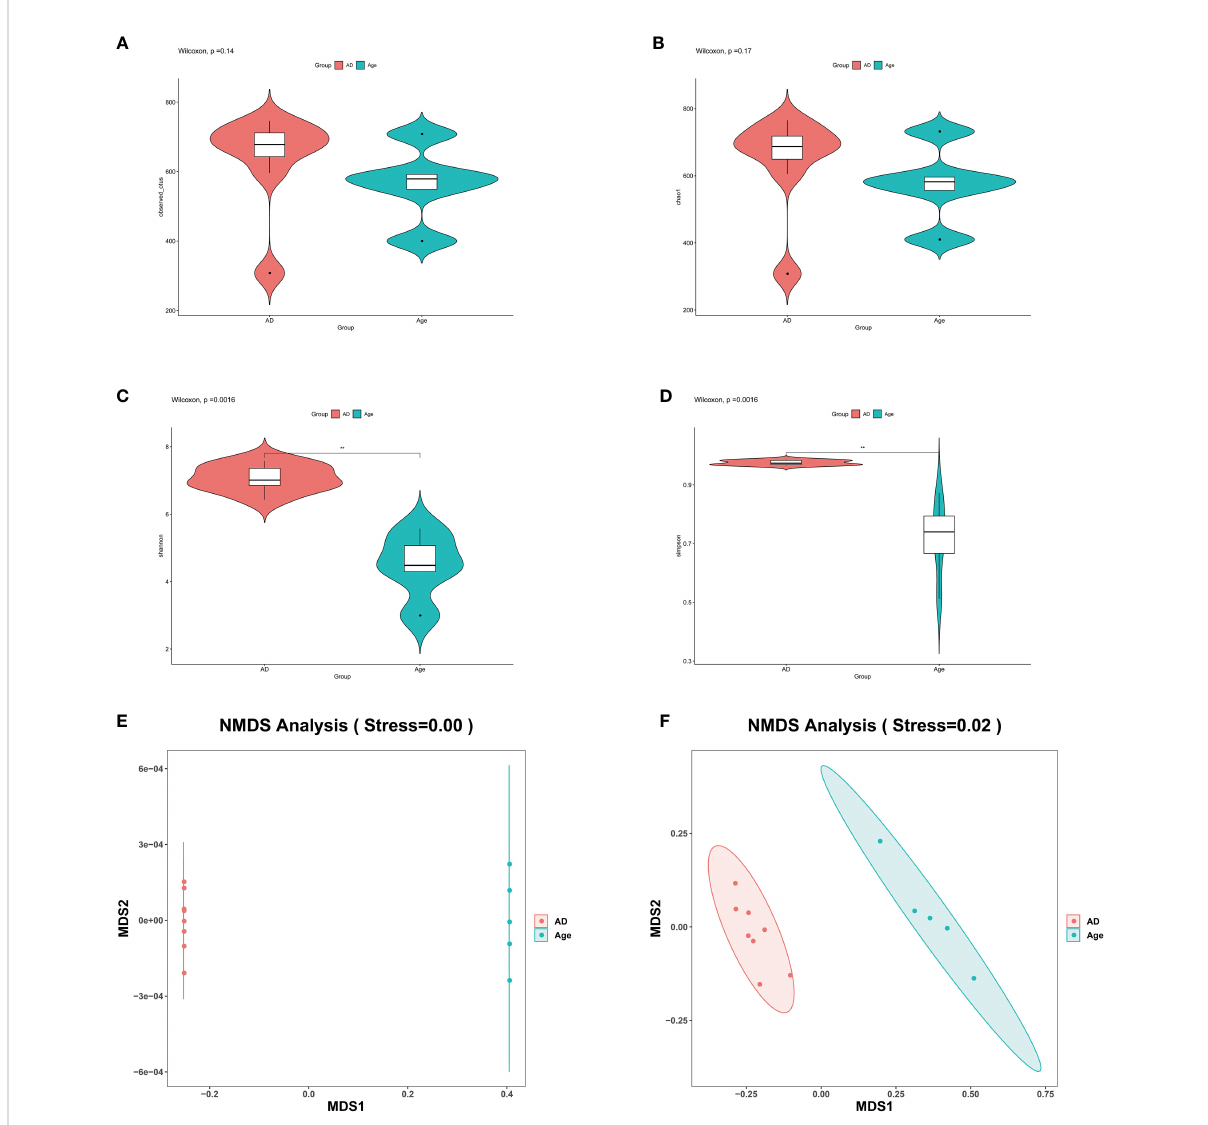
FIGURE 2 Microbial diversity. (A – D) The main purpose of alpha diversity is to re fl ect species richness, evenness, and sequencing depth. To re fl ect richness and uniformity, we used the Chao1, observed species, Shannon, and Simpson indexes. (E, F) b diversity re fl ects the microbial richness within and between groups. We used NMDS to observe the differences between samples. As shown in the fi gure, the two samples are far apart. The two groups of microbiota differ signi fi cantly, and the difference is statistically signi fi cant. *P< 0.05, **P< 0.01, ***P<